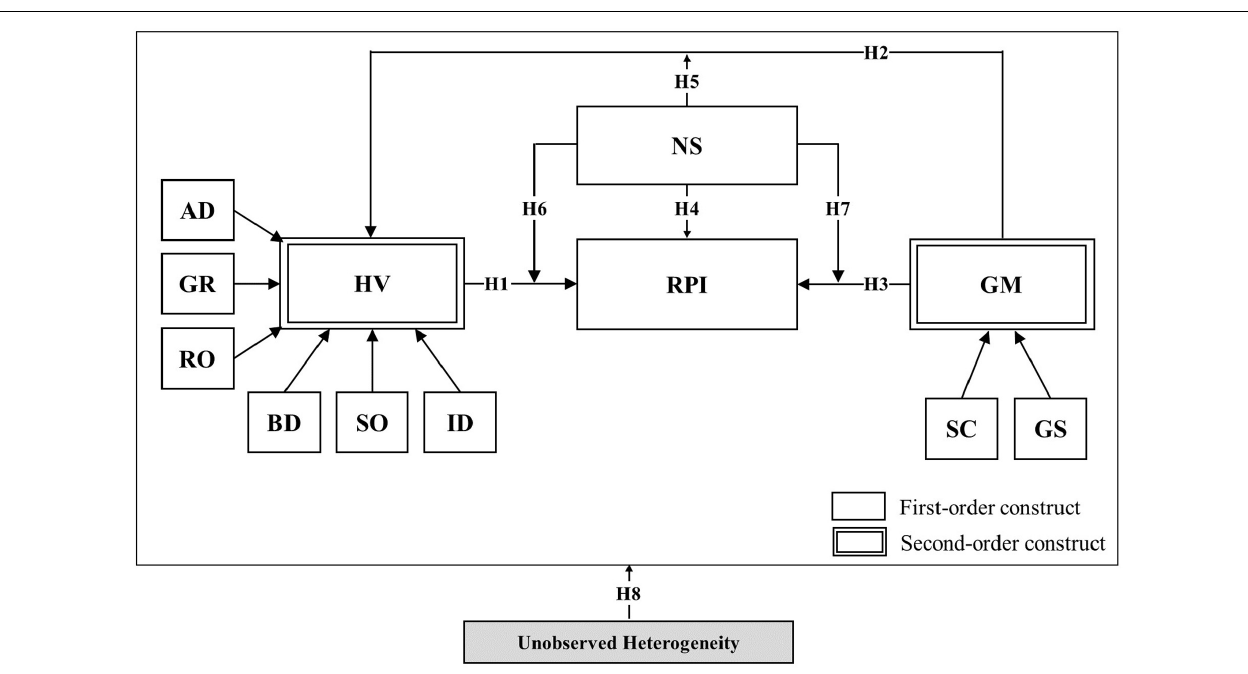
FIGURE 1 | Proposed initial research model in the context of omnichannel retailing.